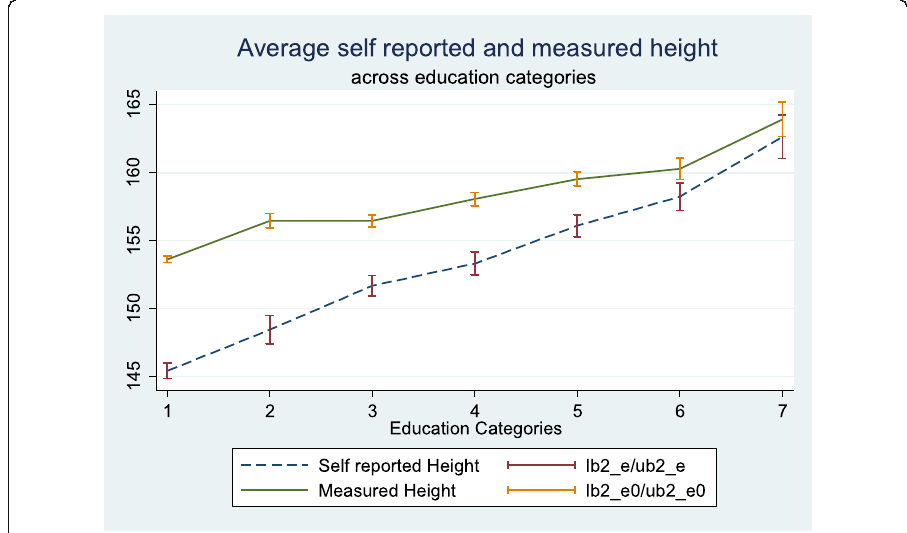
Fig. 3 Average self-reported and measured height by education categories. Note: Categories include: No formal education (=1), below primary(=2), primary (=3), secondary(=4), high school(=5), college (=6) Post- graduate degree